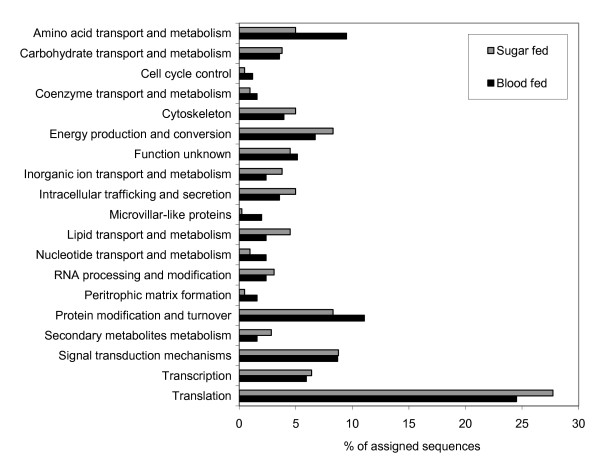
Distribution of clusters from the sugar fed and blood fed libraries in general functional classes. Significant match to the KOG database (E<10E-5) was used as a guideline for grouping the sequences into the functional classes.